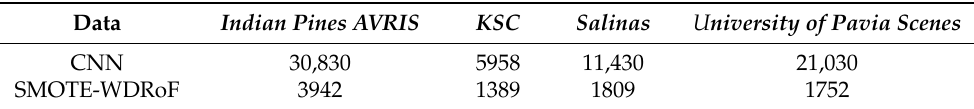
Table 6. Training times (seconds) of CNN and SMOTE-WDRoF for four hyperspectral image datasets.